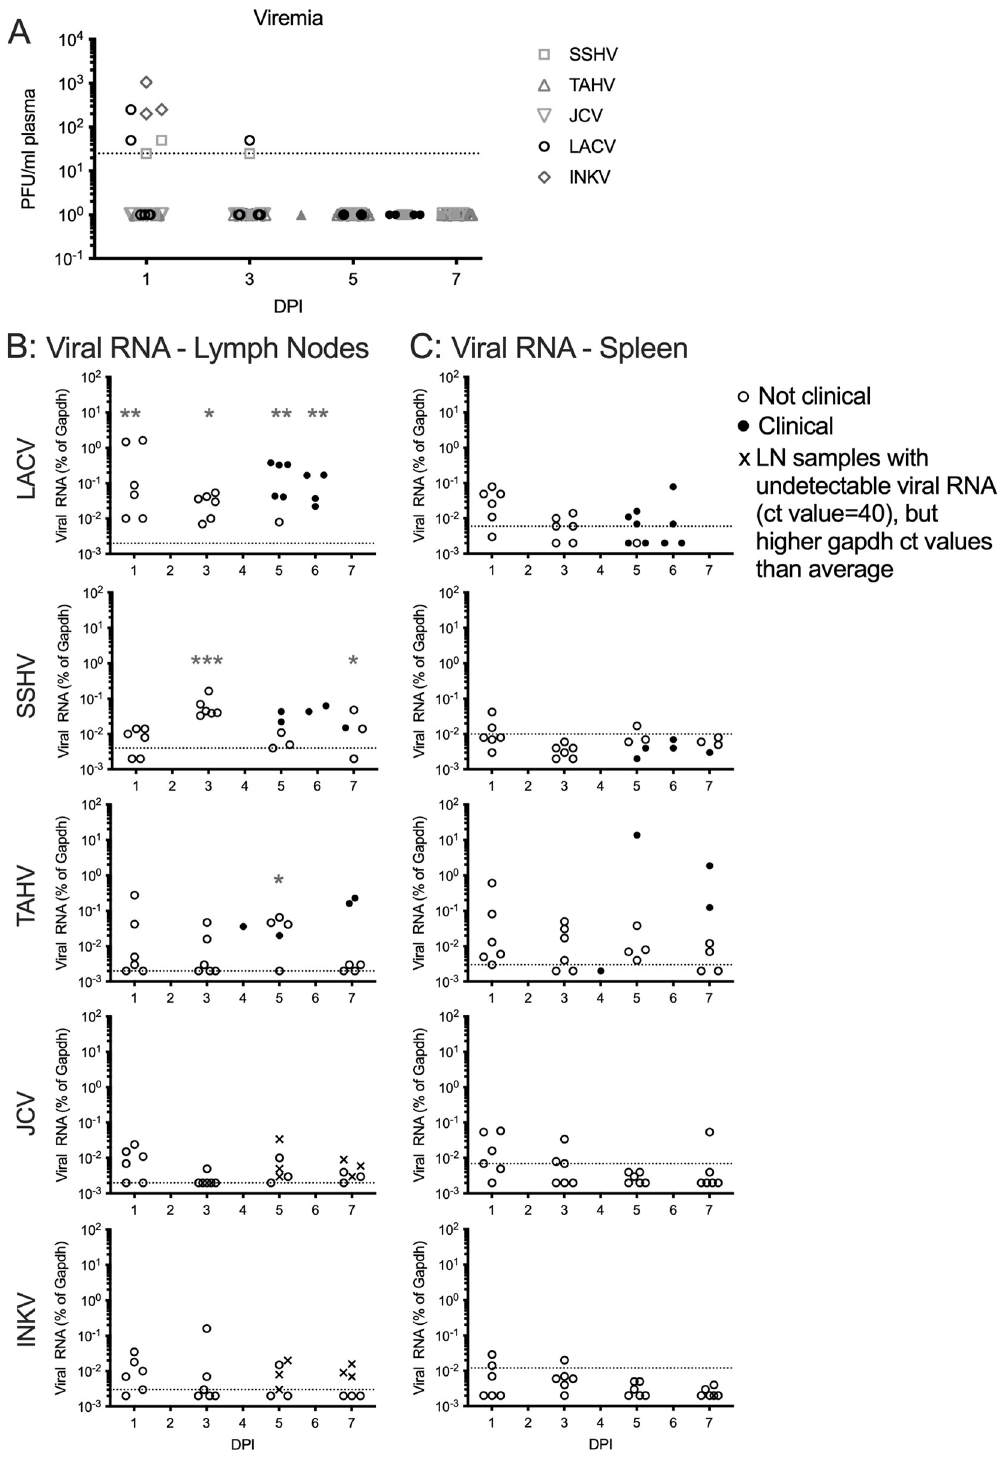
Fig 2. Virus in the periphery. A) Viremias were assessed via plaque assays of plasma samples in Vero cells. Dotted line represents the limit of detection. B-C) Viral RNA levels were analyzed via RT-qPCR with virus-specific primers in lymph nodes (B) and spleens (C). Dotted lines represent mock average from n � 3. Sample numbers are the same as described in Fig 1. Individual points represent individual mice. Dunnett’s multiple comparisons tests were done for each virus, tissue, and time point compared to mock, using Log2(%gapdh) values. Asterisks indicate sample days that had significantly higher viral